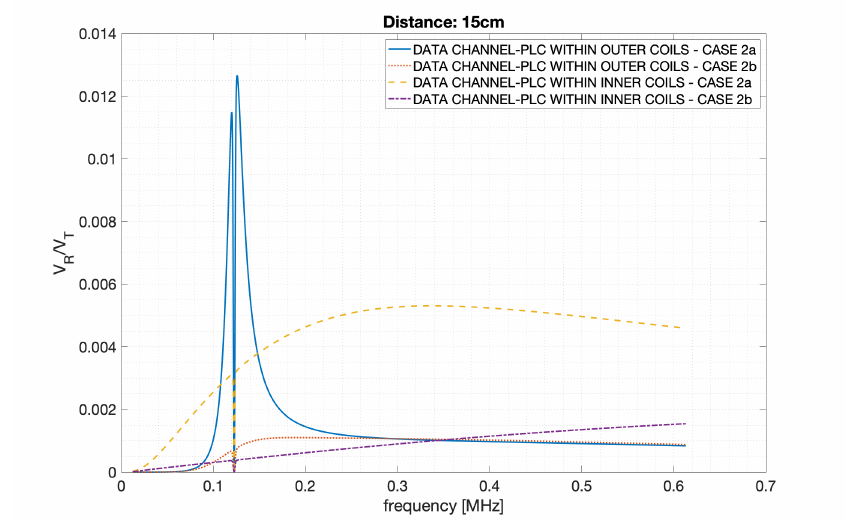
Figure 16. Transfer function comparison for the data channel, Case Study 2.